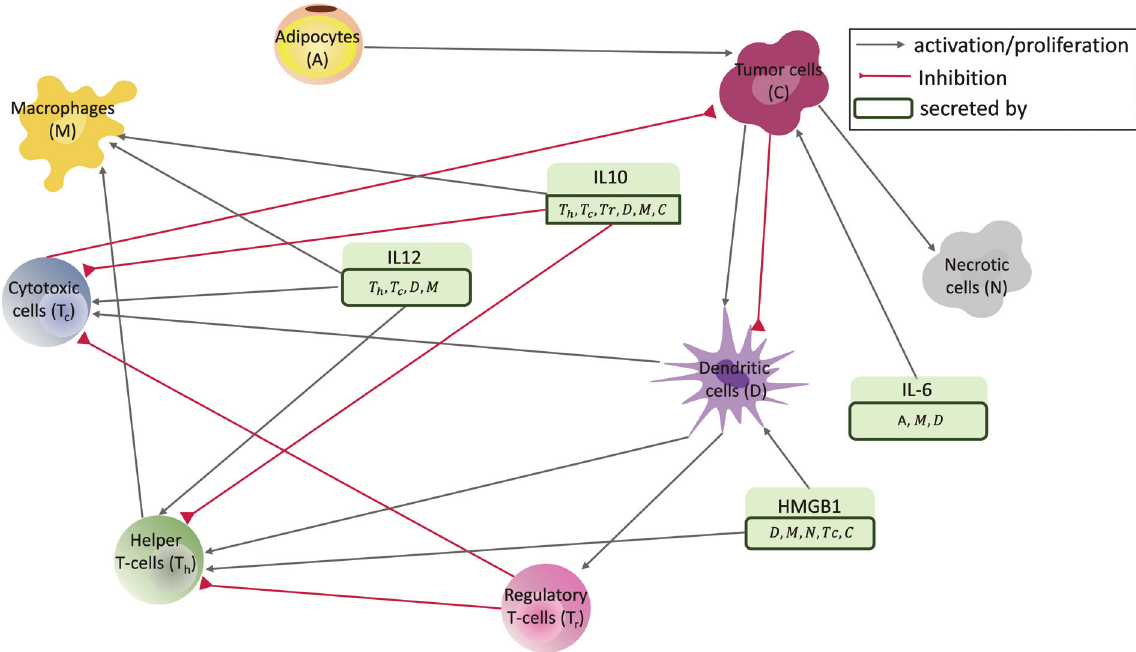
Fig 1. Interaction network. Diagram of interactions between different cell types and molecules in breast tumors for the mouse model, as it has been modeled in this paper. Variables of the model with their descriptions are given in Table 1.